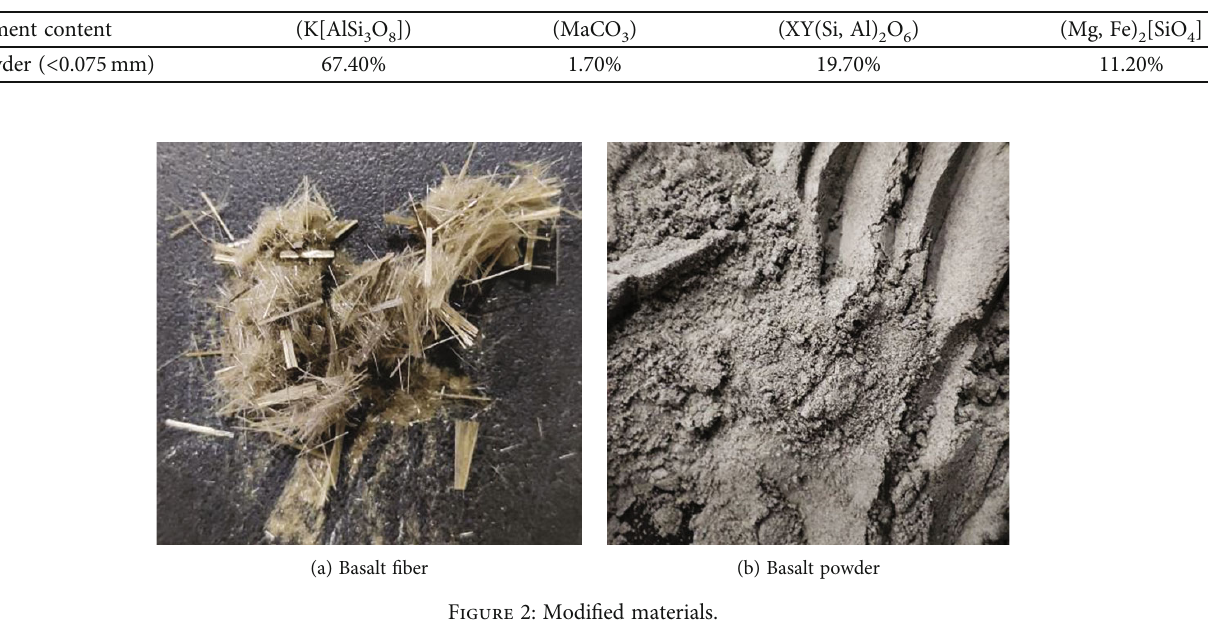
Table 3: Composition of basalt powder.